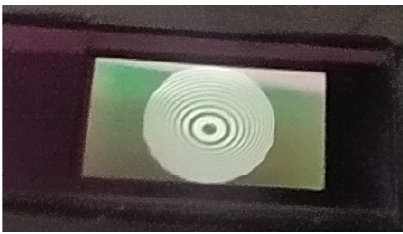
Figure A3. AZP for aberration related to Figure 5d.